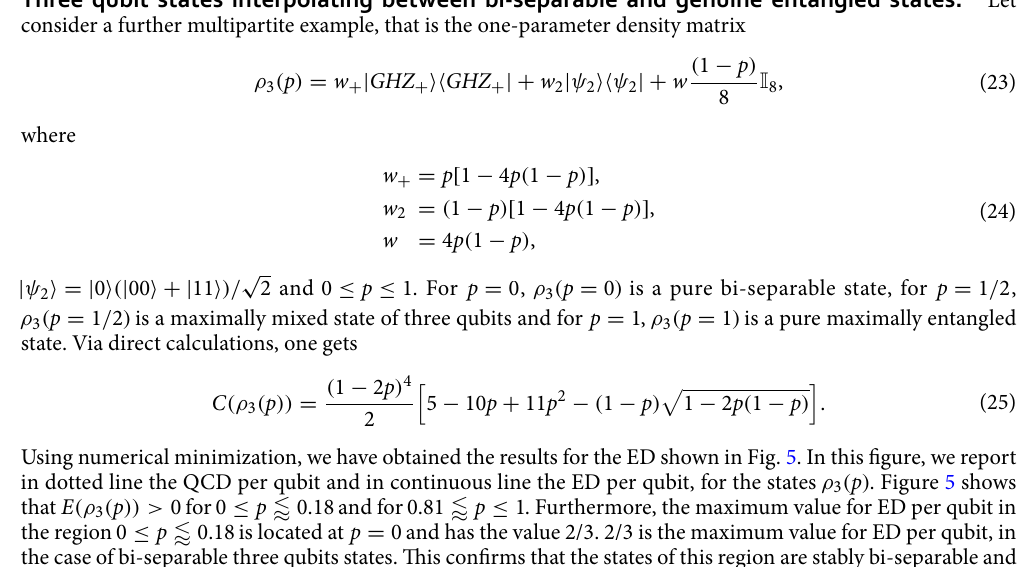
ρ 3 ( p )/ 3 (dotted line) and E Figure 5. C [ ] 1 ) is, as expected, the maximally entangled one, and that the states ρ 3 ( p > 0.81 ) or ρ 3 ( p < 0.18 ) are state ρ 3 ( p = not